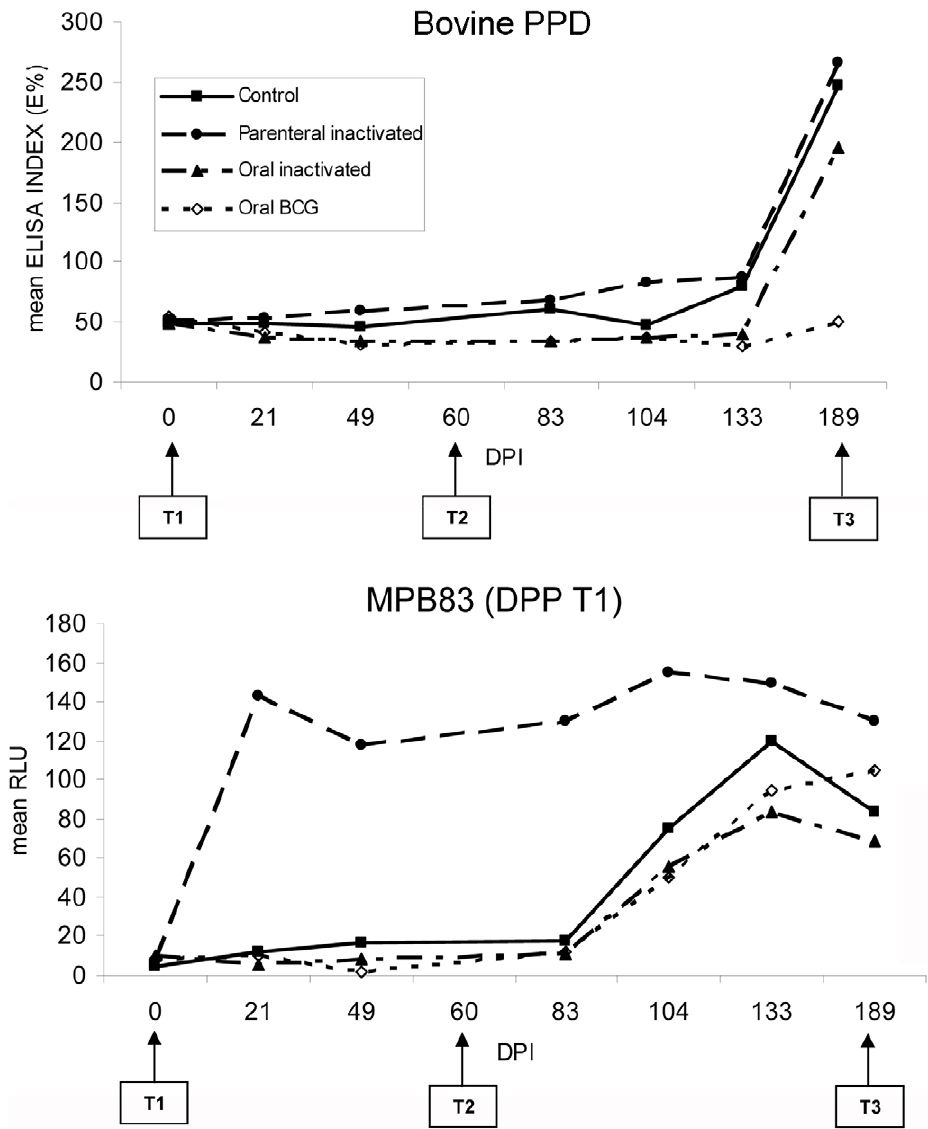
Figure 2. Serum antibody response after vaccination and after challenge. Mean serum antibody response (n=5 for each point and group) as measured by the bPPD ELISA (in ELISA percentage, E%) and the MPB83 dual-path platform test (DPP-T1, in relative light units, RLU).